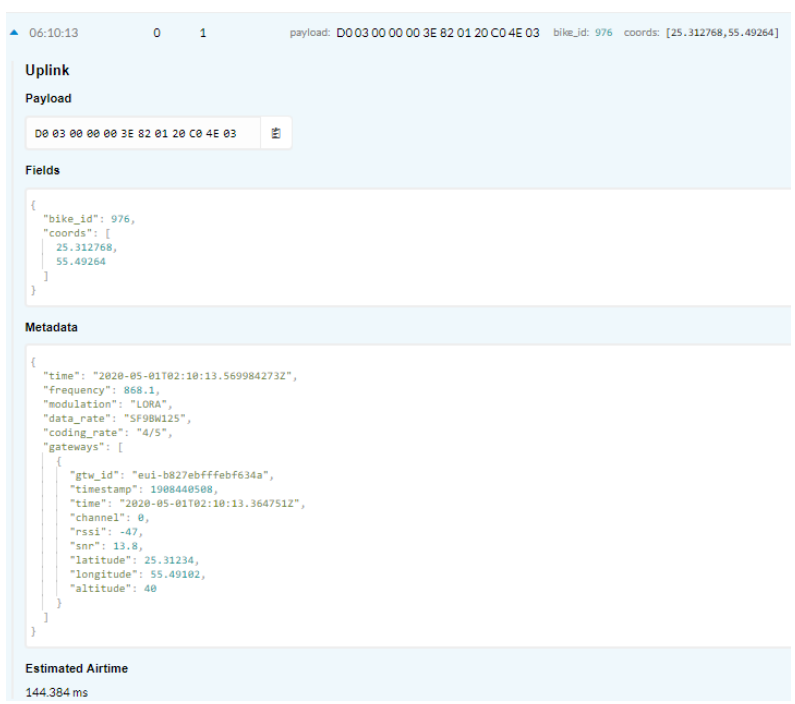
Figure 8. Decoded decrypted payload with sensor information at the network server.